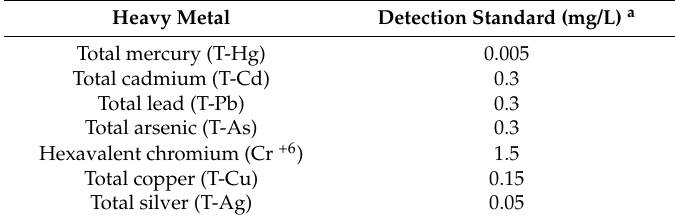
Table 3. The limits of heavy metals involved in green building material